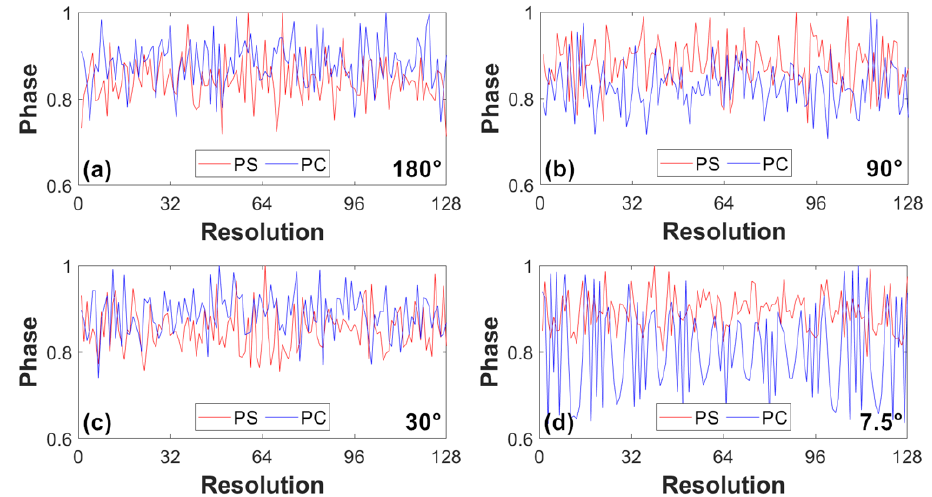
Figure 9. Error of the diffraction results between PS (red line) and PC (blue line) method in phase with different flare angles of WRP. ( a ) 180 ◦ , ( b ) 90 ◦ , ( c ) 30 ◦ and ( d ) 7.5 ◦